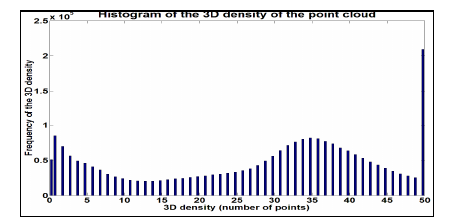
Figure 11. Histogram of the 3D density of the point cloud- Dalhousie St data.